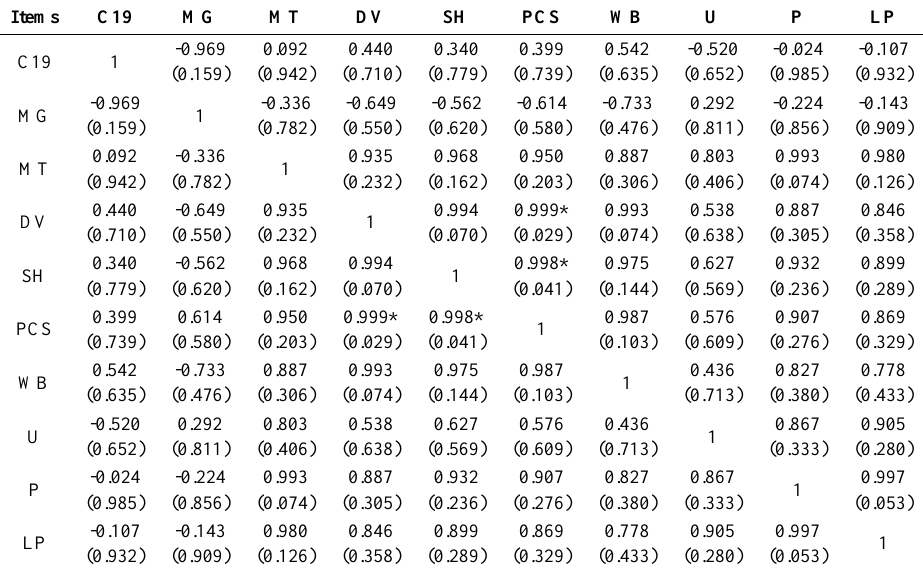
Table 3. Summary of Pearson correlations (*p